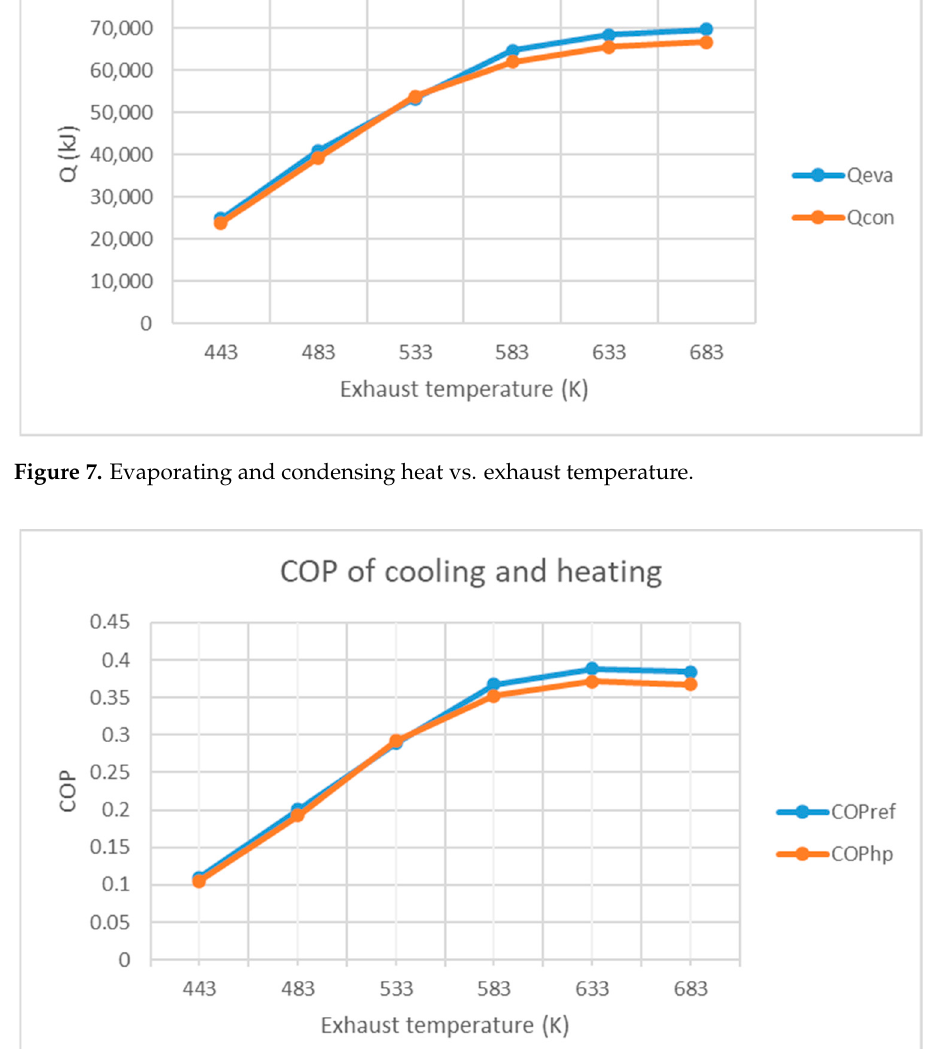
Figure 8. Refrigeration and heat pump coefficient of performance (COP) relative to exhaust temperature.